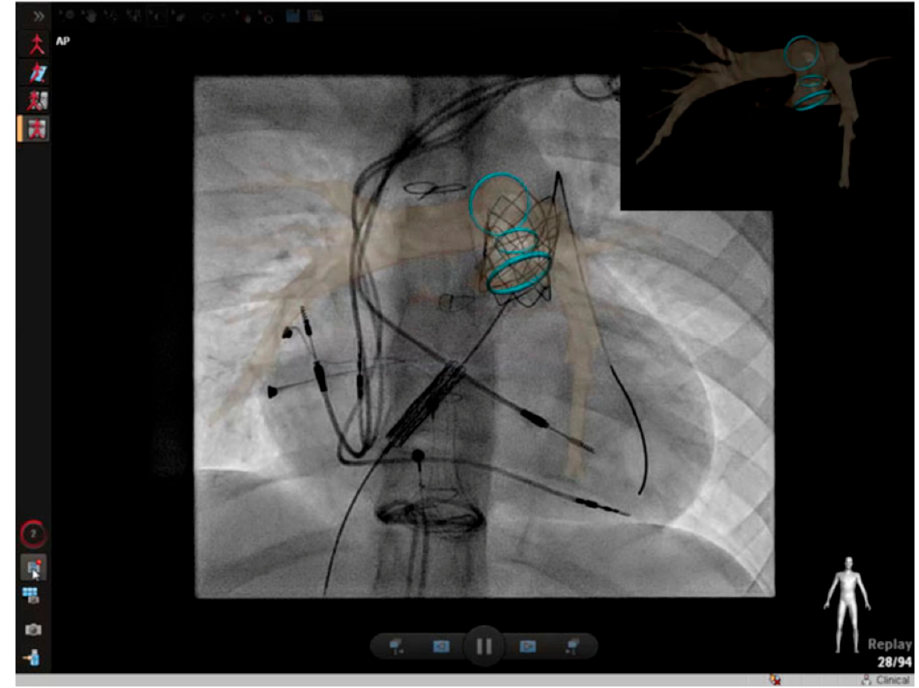
Figure 17. Patient is status post Tetralogy of Fallot conduit repair who now presents for fluoroscopic overlay guided percutaneous stent and pulmonary valve placement. The blue circles represent the optimal landing zone. Revised from ref [9].